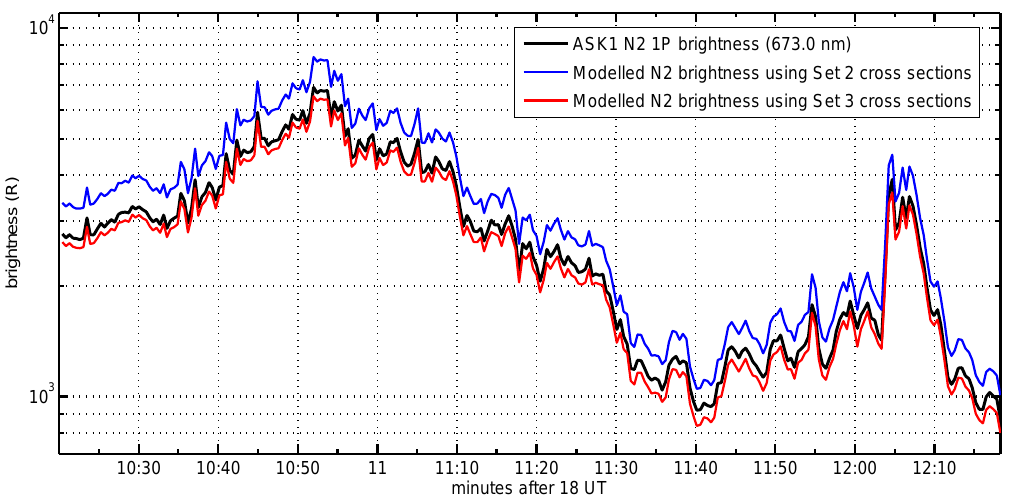
Fig. 7. Comparison between ASK1 (673.0nm) measured intensity (black) and modelled N 2 1P emission using cross sections from Set 2 (blue) and Set 3